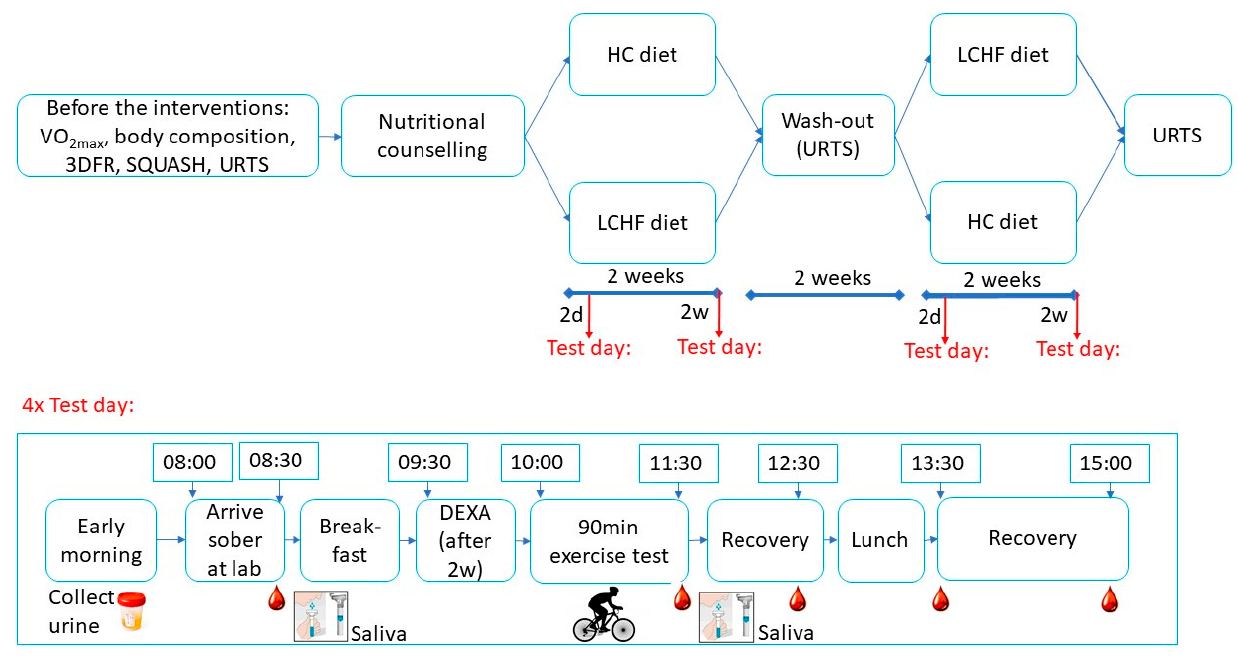
Figure 1. Study design. Schematic study design, 3DRF: 3-day food record; SQUASH: Short Questionnaire to Assess Health enhancing physical activity; URTS: Upper respiratory tract symptoms questionnaire; 2d: after 2 days on the diet; 2w: after 2 weeks on the diet; DEXA: dual energy x-ray absorptiometry.